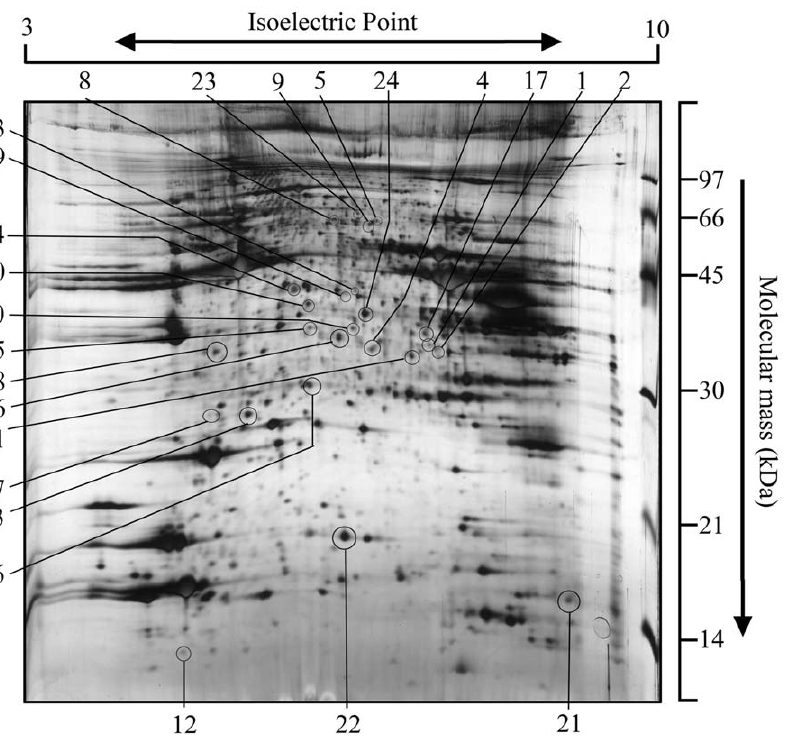
Figure 4. Quadriceps femoris protein profiling by 2-DE. A typical 2-D-pattern gel image of 100- m g protein extract separated in a pH 3–10 IPG strip in the first dimension and 13% polyacrylamide gel in the second dimension. One 2-D gel was performed each sample, 6 samples per group. Twenty-five differentially expressed (p , 0.05) spots were labeled with spot number as they appear in the MS list (see Table 2).